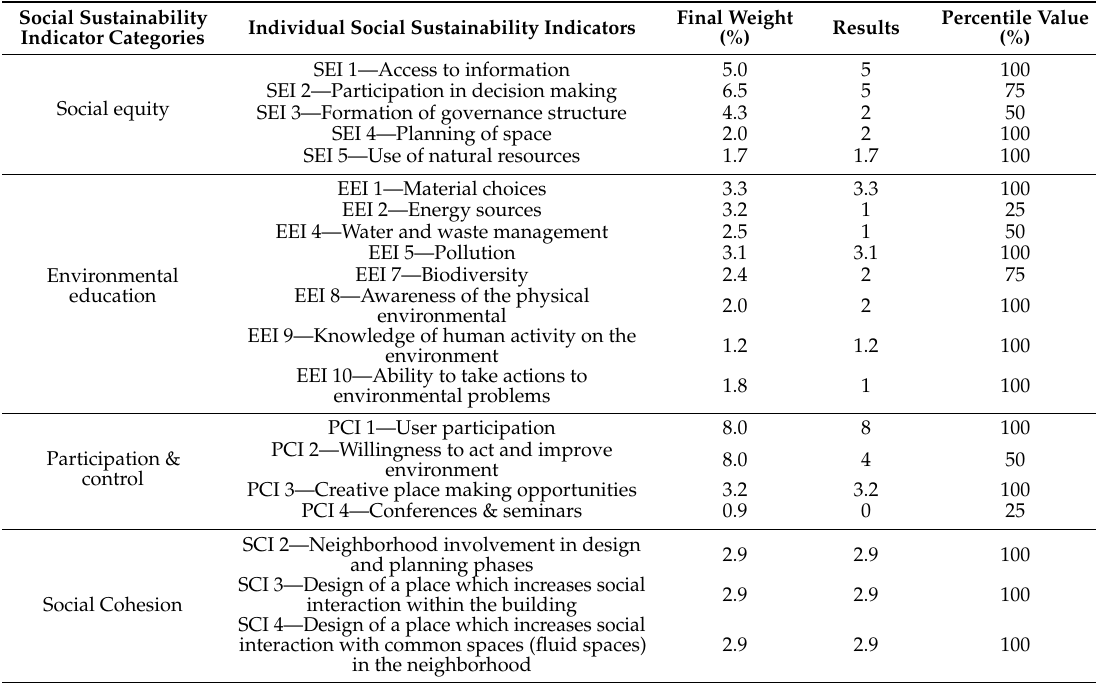
Table 7. Results which led to the